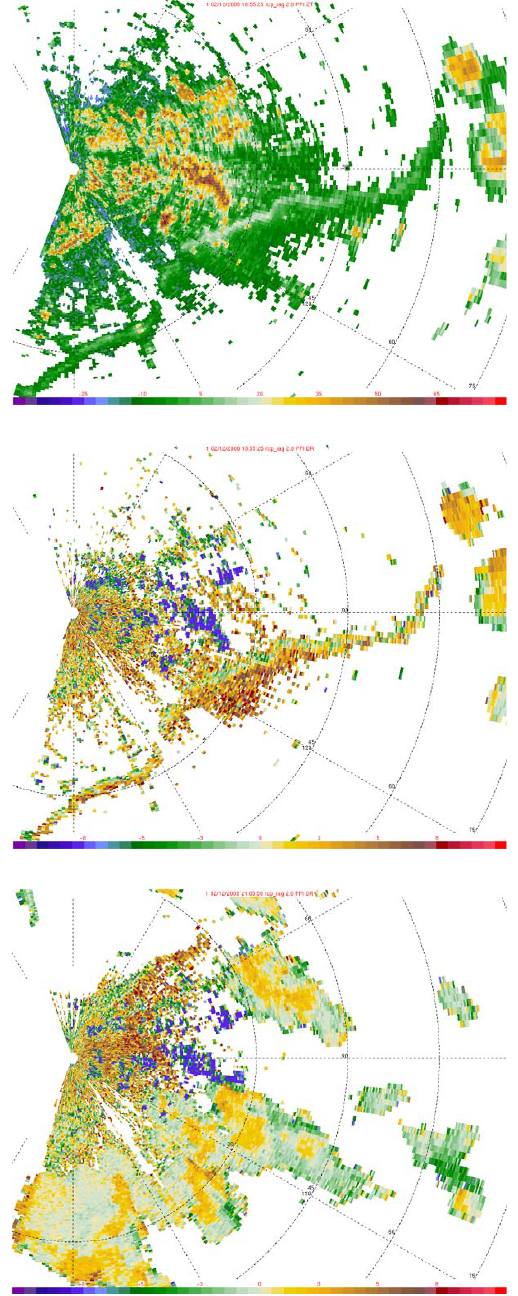
Fig. 7. 2 ◦ PPI of reflectivity – Z h (a) and differential reflectivity – Z DR (b) obtained with MXPOL at 18:55UTC and Z DR (c) at 21:05UTC on 12 February 2008. Colour scales are